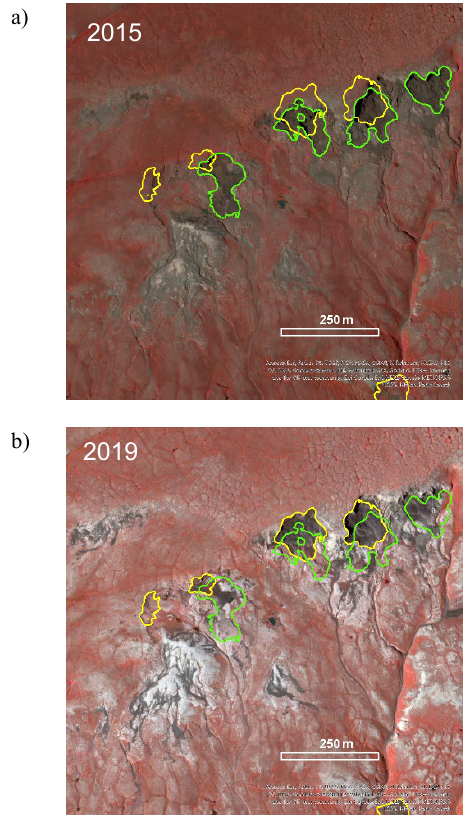
Figure 16 . Multi-temporal RTS detection. (a) and (b) represent satellite images acquired in 2015 and 2019, respectively. The green outline corresponds to the RTS detection based on the 2015 image whereas the yellow outline corresponds to the RTS detection based on the 2019 image. (Imagery © 2016 DigitalGlobe,